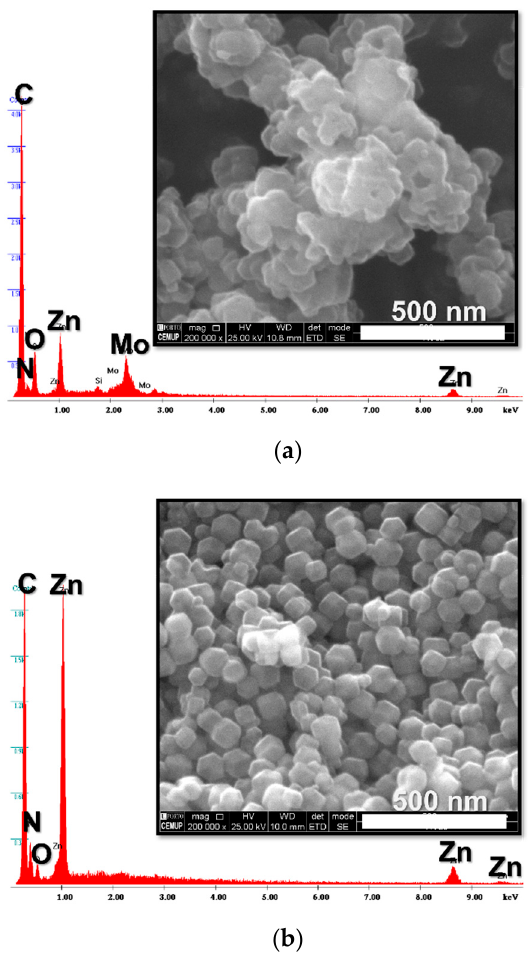
Figure 2. SEM micrographs and corresponding EDS spectra obtained for ZIF-8 ( a ) and [BMIM] 3 PMo 12 @ZIF-8 ( b